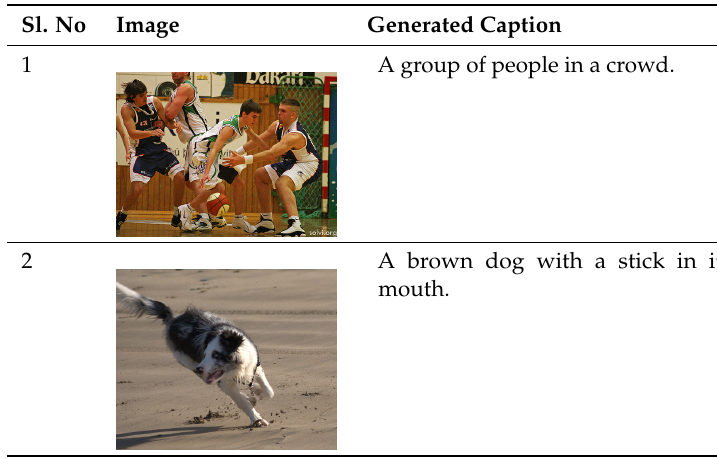
Table 3. Partially successful